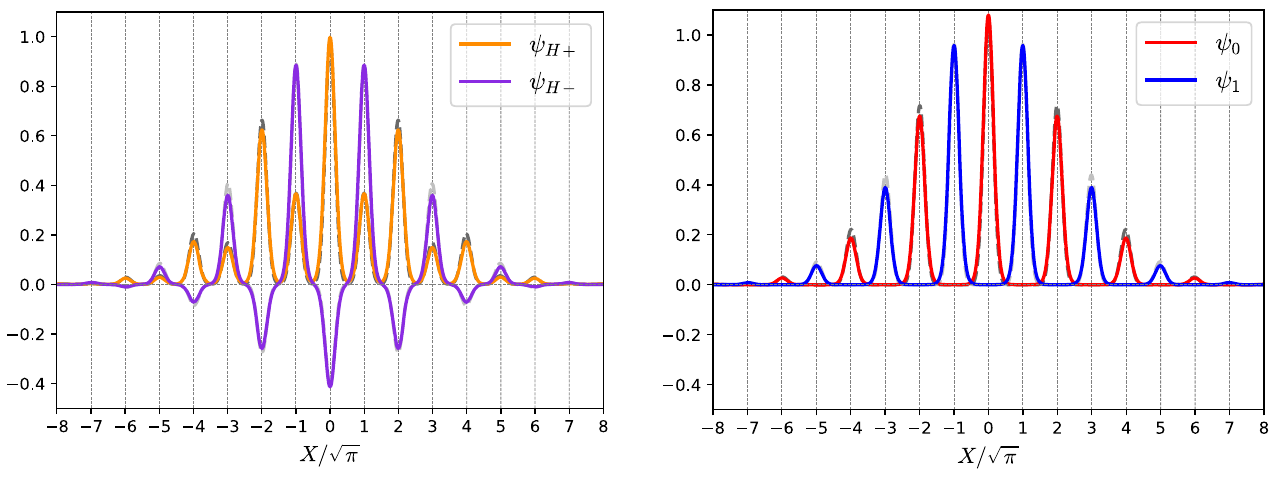
FIG. 6. Numerically obtained lowest-energy eigenfunctions ψ X Þ of the effective Hamiltonian in Eq. (30) for ℏ ω 2 0 = ω H (cid:4) ð 0 . 05 , which corresponds to Δ ¼ 0 . 25 ; see Eq. (33). The quasi- degenerate eigenfunctions are even and odd under Fourier transforming, respectively, and are well approximated by the analytic expressions (dashed light and dark gray lines, respec- tively) in Eq. (31).